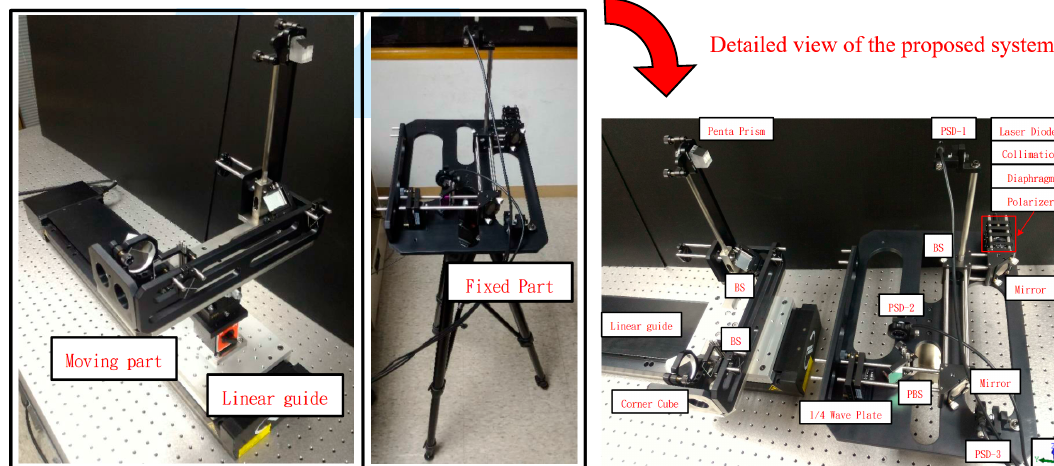
Figure 10. Photograph of laboratory-built prototype.